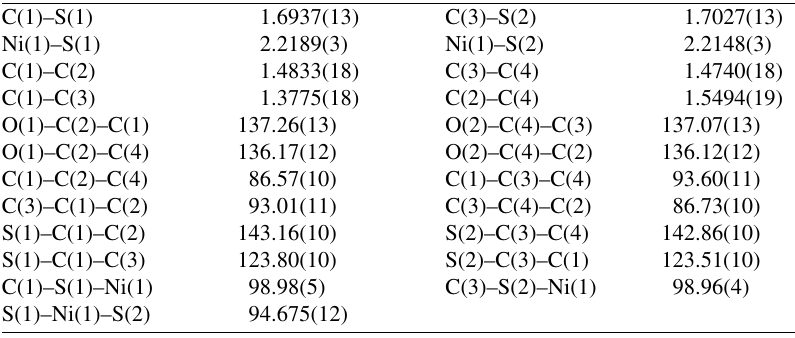
[ Ni(dtsq) ] P) 3 2 2